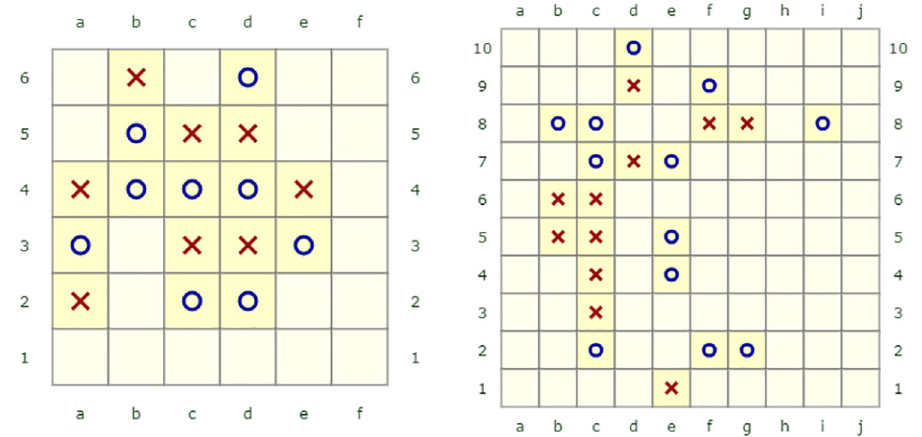
Fig 1. Examples of board configurations. Left, board I (6x6 squares) full condition, ‘X’ wins within 4 moves (correct solutions are ‘f3’ or ‘f5’). Right, board IV (10x10 squares) full condition, ‘X’ wins within 5 moves (correct solution is ‘e8’).